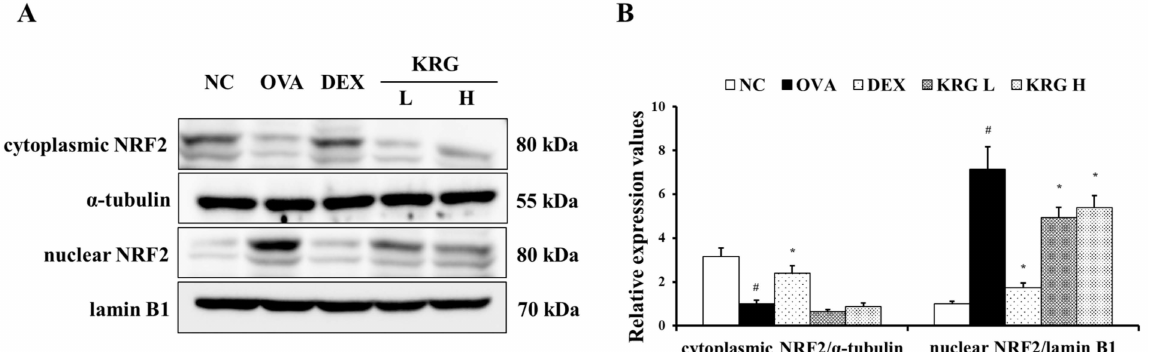
Figure 6. Korean red ginseng (KRG) reduces the translocation of nuclear factor erythroid 2-related fac- tor 2 (NRF2) into the nuclei ( A ) in the lung tissue induced by ovalbumin (OVA) treatment. Densitomet- ric values ( B ) were determined utilizing Chemi-Doc. Normal control (NC) group; mice administered with the vehicle, OVA, group; mice treated with OVA and administered with the vehicle, dexametha- sone (DEX), group; mice treated with OVA and administered with dexamethasone (3 mg/kg); KRG low (KRG L) and high (KRG H) groups; mice treated with OVA and administered with KRG (100 and 300 mg/kg, respectively). Values: means ± standard deviation ( n = 6). Significance: # p < 0.05 vs. NC; * p < 0.05 vs.